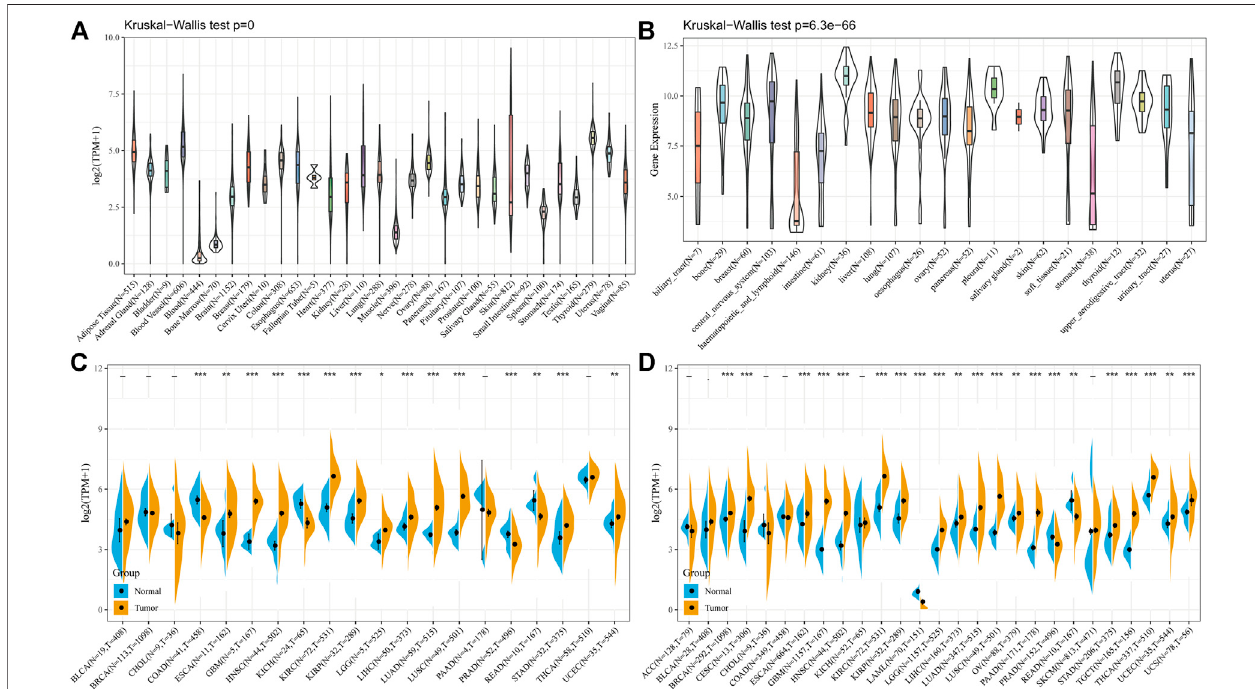
FIGURE1| The PLOD2 expressionlevelinhumanpan-canceranalyses. (A) Expressionof PLOD2 innormaltissuesinGTEx. (B) Expressionof PLOD2 inCCLE. (C) Thelevelof PLOD2 inTCGA. (D) TheexpressionlevelinTCGAcombinedwithGTEx.Theblueandyellowbargraphsindicatenormalandtumortissues,respectively.* p < 0.05; ** p < 0.01; *** p < 0.001. The signi fi cance of the two groups of samples passed the Wilcox